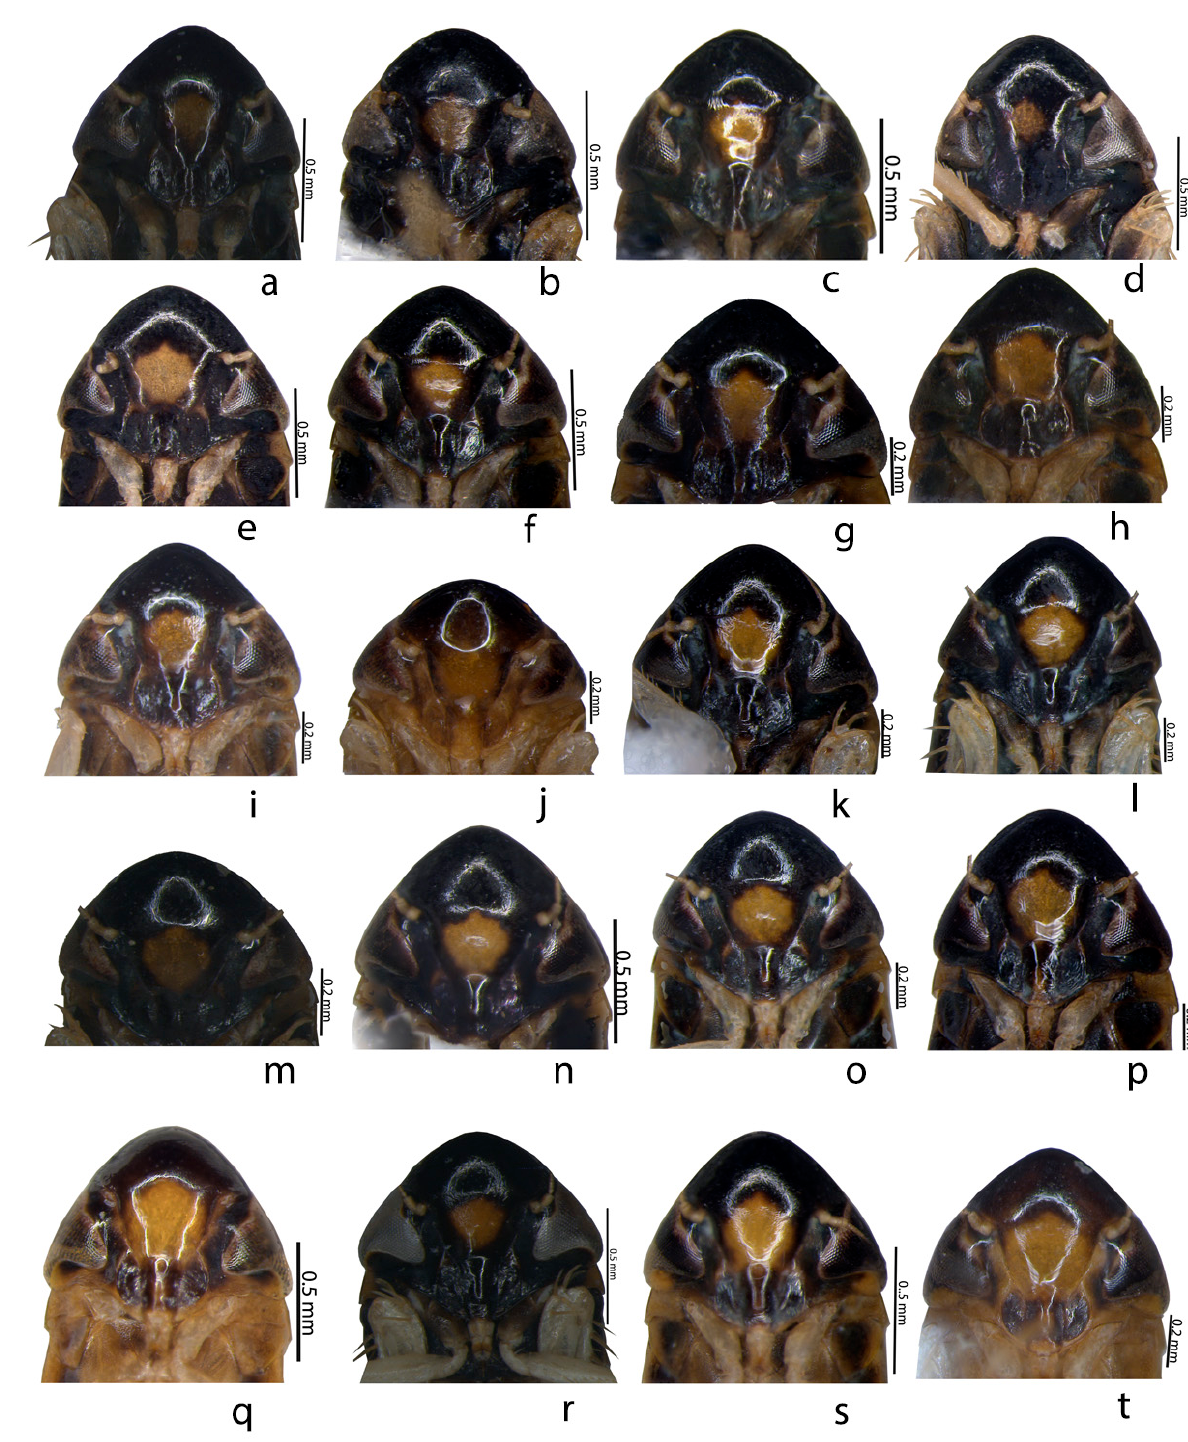
Figure 3. Colour polymorphism in Mukaria splendida Distant. ( a – j ) ♂ face; ( k – t ) ♀ face. Male Genitalia: The pygofer was 2.5 x wider than long, with a prominent T-shaped caudal ventral process on each side and an anal tube with microsetae (Figure 4a,b). Sub- genital plates were wider, extending beyond the pygofer both laterally and posteriorly with a few macrosetae (Figure 4c). The valve triangle (Figure 4c) was articulated with pygofer. The style was broad at the base and slightly curved in the posterior region;the